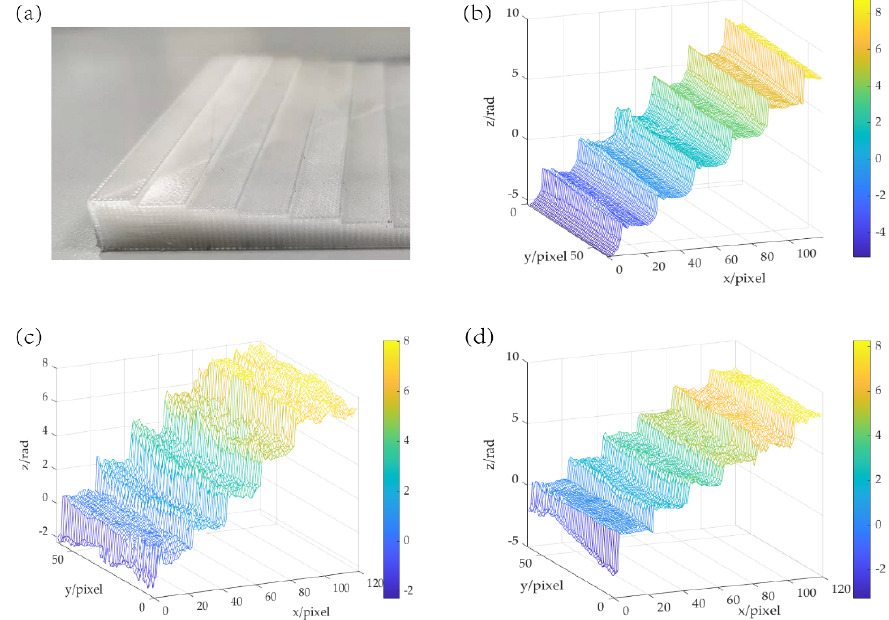
Figure 7. The phase distribution of the step captured. ( a ) Photo of the object ( b ) by RSFPI at 0.3 THz with NA = 0.24, ( c ) by conventional MPPR with 500 iterations and ( d ) by the UE-MPPR method with the ∆ F # = 8, 300 iterations.